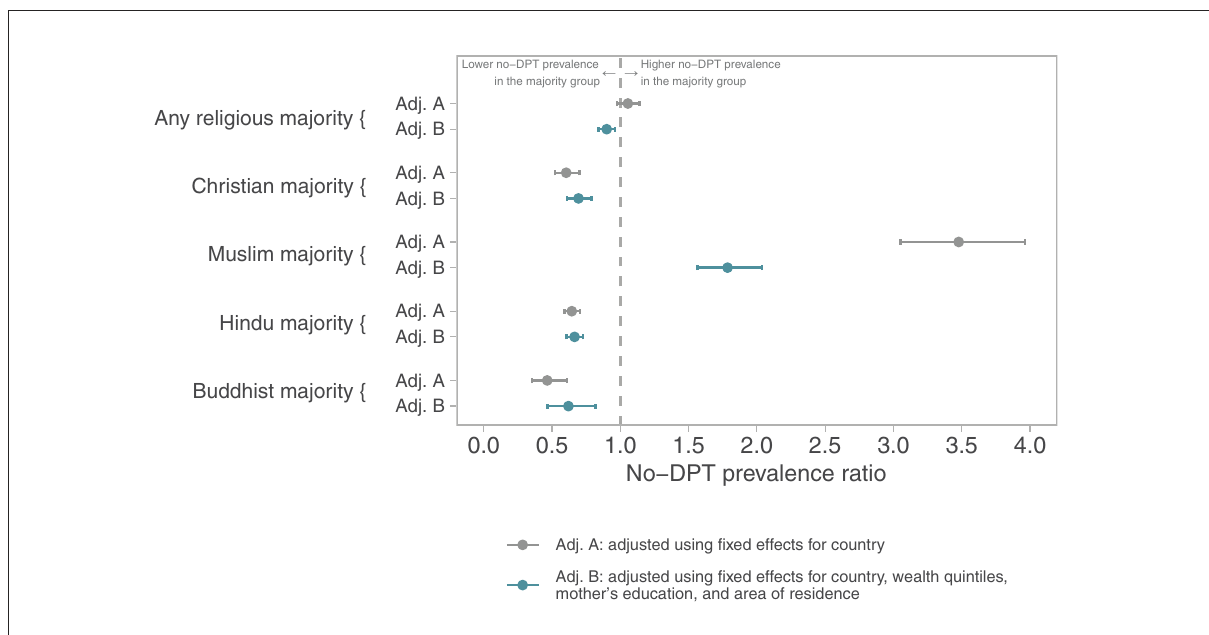
FIGURE2 No-DPT prevalence ratios comparing the majority religion with remaining children in each country. Poisson regression models with children as the units of analysis, including fixed effects for country (upper lines) and adjusting for wealth, maternal education, and residence (bottom lines).